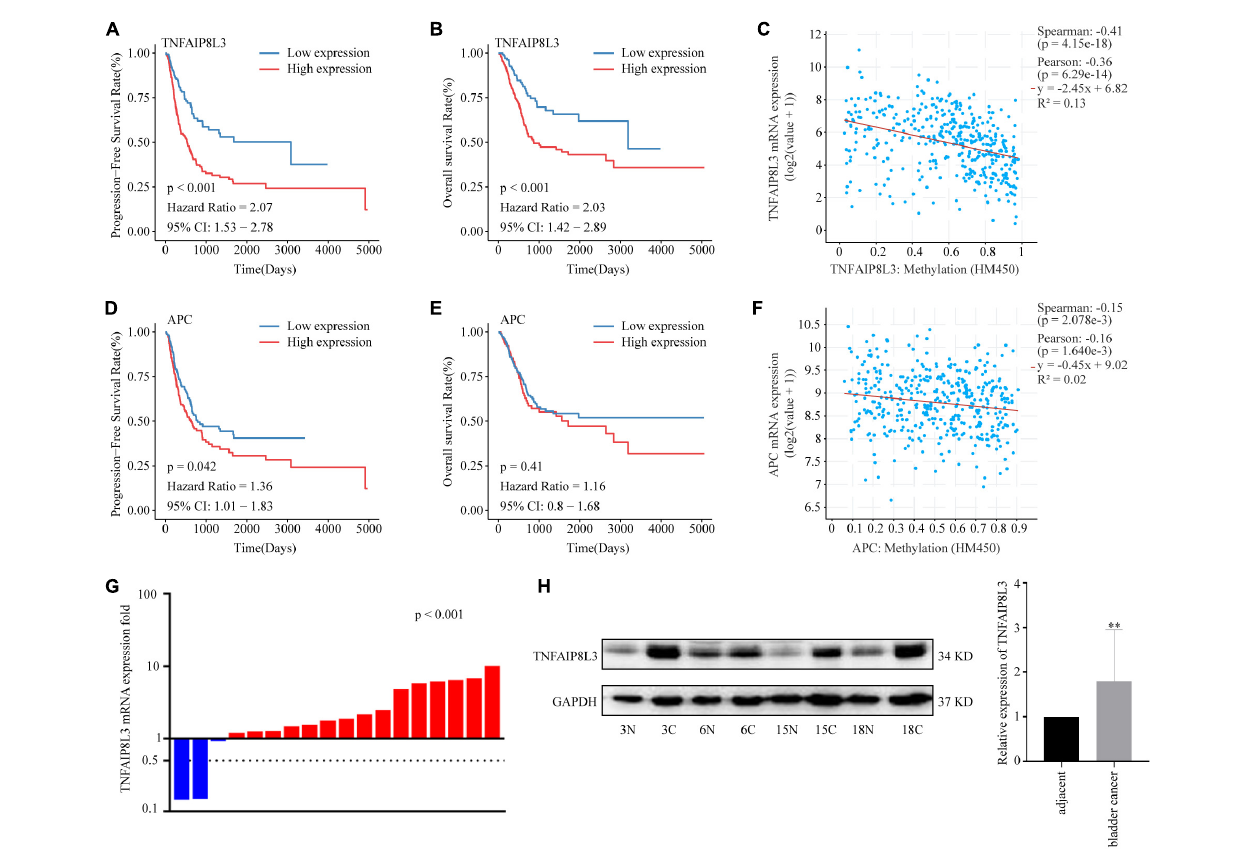
FIGURE 7 | Expression patterns of MRSB component-related genes. (A) Progression-free survival curves according to the presence of the MRSB component-related gene TNFAIP8L3. (B) Overall survival based on TNFAIP8L3 expression. (C) Negative correlation between TNFAIP8L3 expression and the methylation level. (D) Progression-free survival and (E) overall survival curves based on the expression of APC. (F) Negative correlation between APC expression and the methylation level in the ZZU cohort. (G) The mRNA expression levels of TNFAIP8L3 in the cancer and adjacent tissues ( p < 0.001, ZZU cohort). (H) The protein expression levels of TNFAIP8L3, ** p < 0.001. MRSB, methylation risk score for bladder cancer; ZZU, Zhengzhou